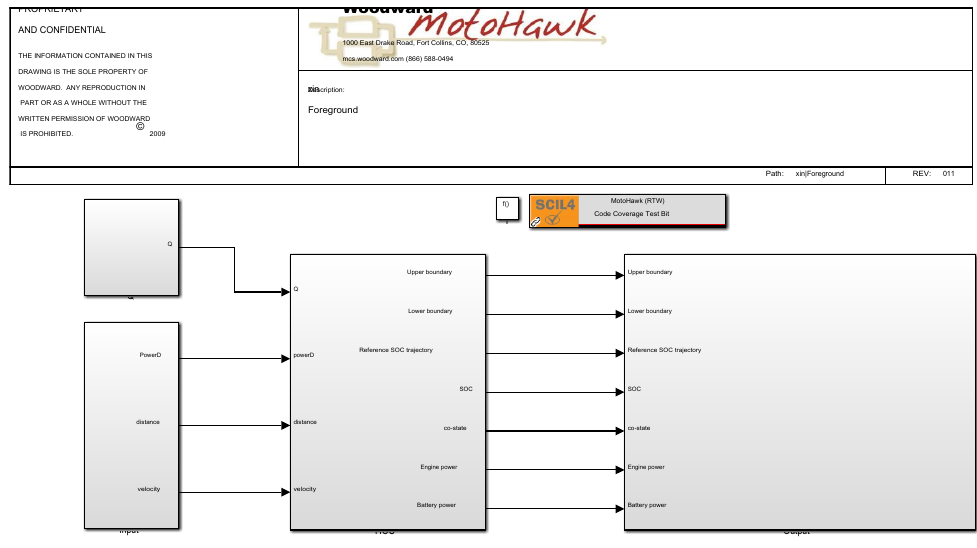
Figure 18. The composition of HIL.